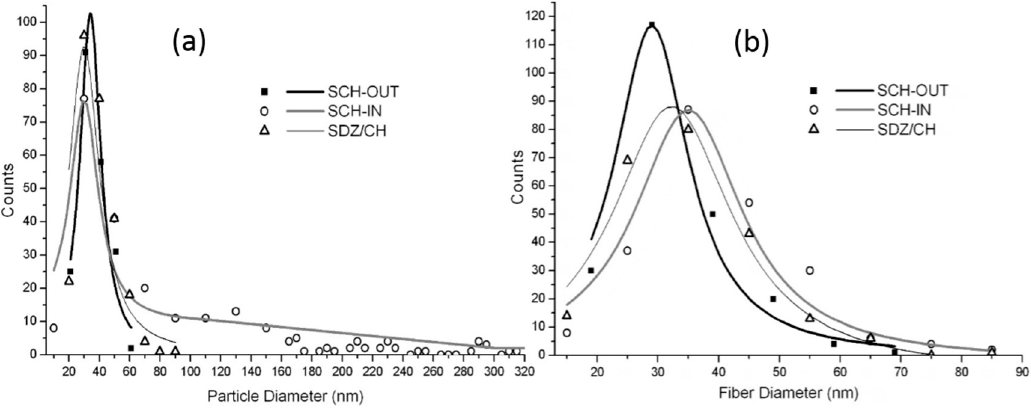
Figure 3. Particle ( a ) and fiber ( b ) size distributions for SCH-IN, SCH-OUT and SDZ/CH samples (to facilitate the visualization the data points were interpolated).